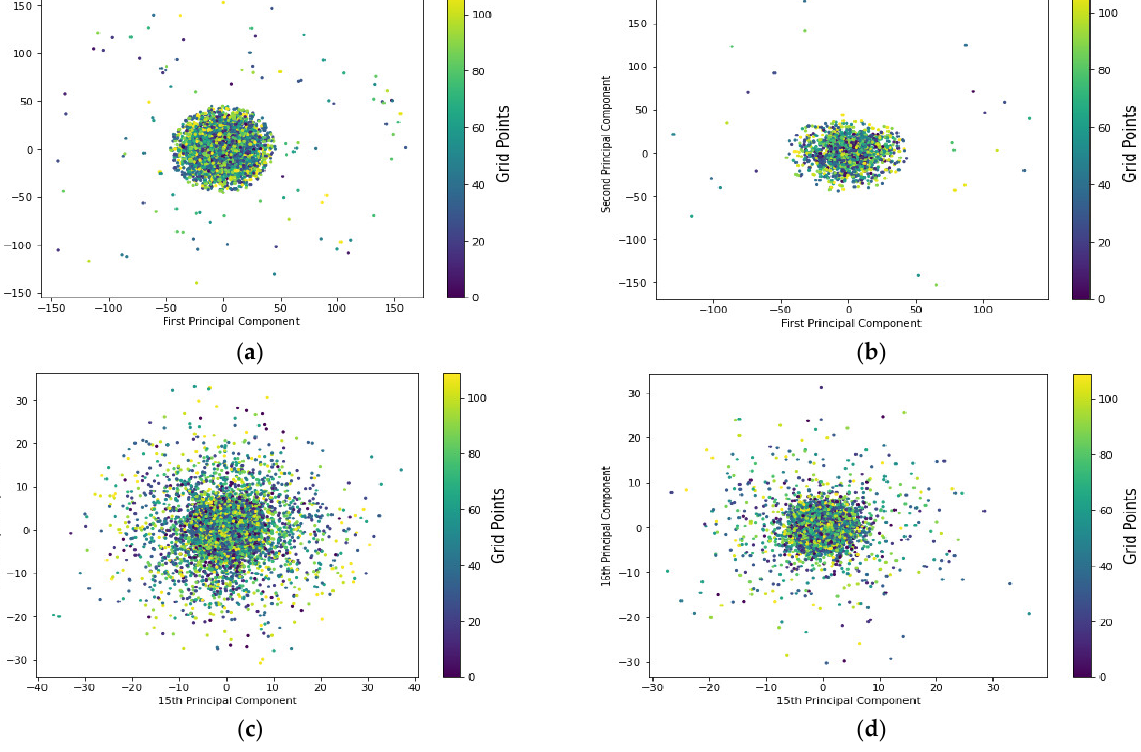
Figure 8. Distribution of principal components of fused data of month 2 with their corresponding RPs. ( a ) Training Fused data of Month 2, ( b ) Testing Fused data of Month 2, ( c ) Training Fused data of Month 2, ( d ) Testing Fused data of Month 2. Table 4. Effect of feature spaces to the variance account of the predictive model for indoor parking lots using Fused data: M1(#RPs = 225) .